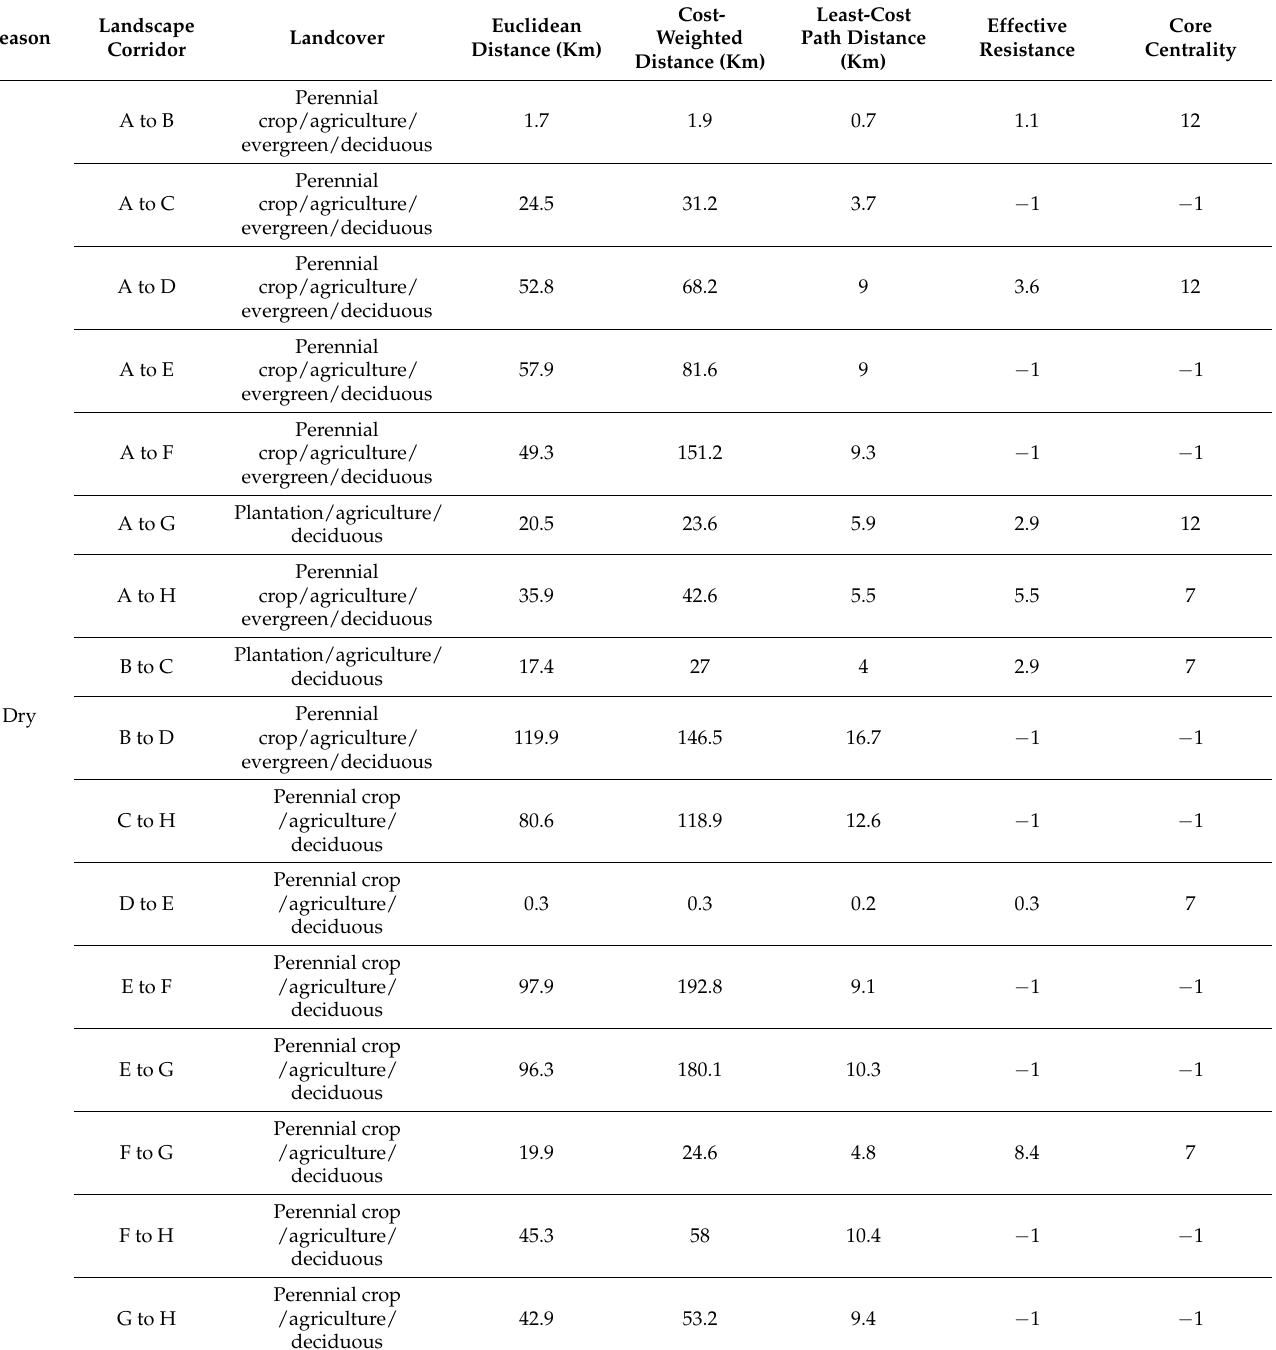
Table 4. The landscape corridors with Euclidean distance, cost-weighted distance, least-cost path distance, effective resistance, and core centrality of wild elephants in the eastern part of